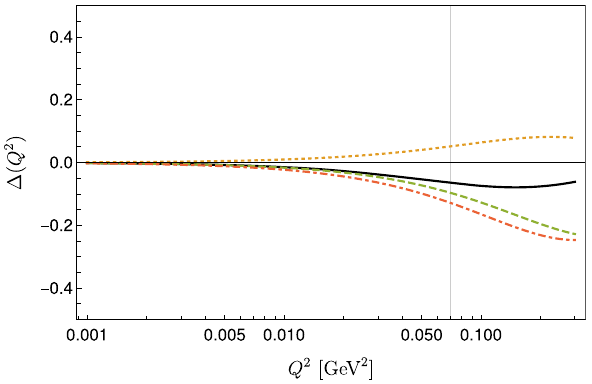
Fig. 9 The quantity (cid:15)( Q 2 ) (45). Full black line stands for lattice data [20], dotted yellow line for the calculation performed within the univer- sal model [36], dashed green line represent the result of the evaluation within the original model [34] and dot-dashed red for the dynamical spin model [44] in the A = B = 1